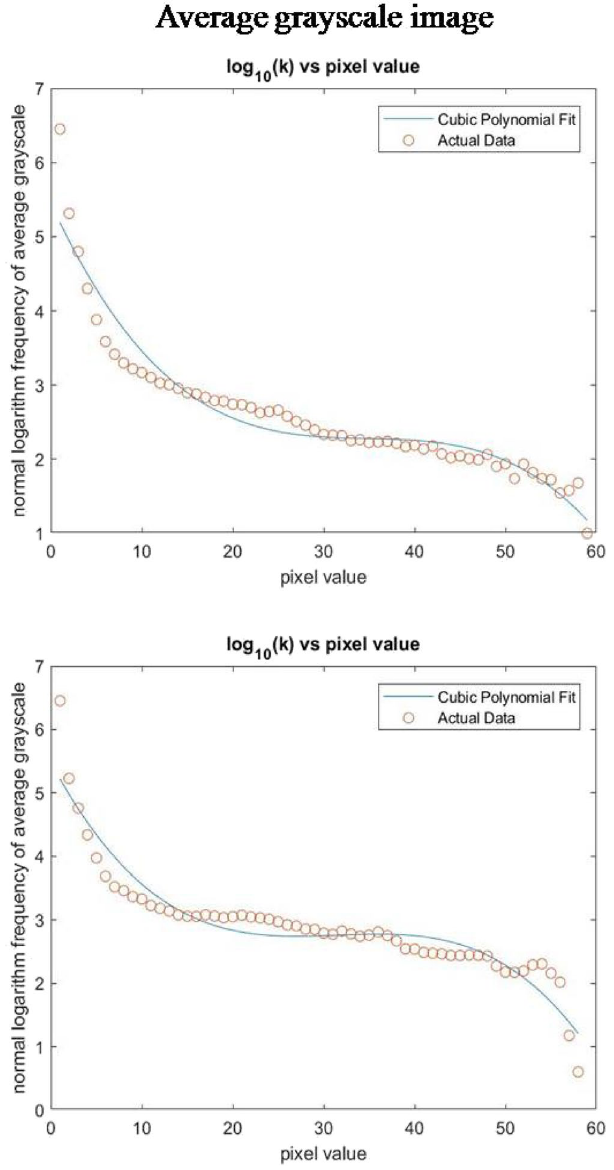
Figure 8. Frequency distribution curves of images in Fig.